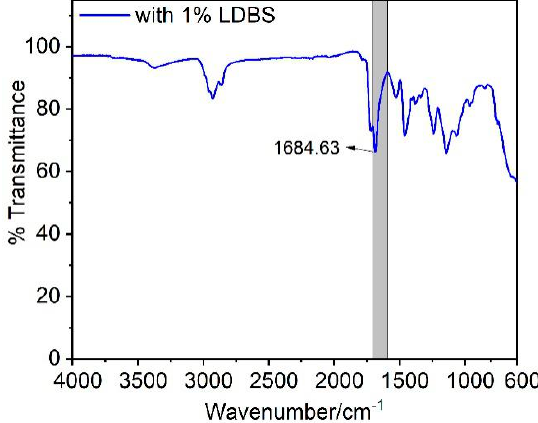
Figure 8. Integral area of the carbamate carbon’s characteristic peak of the sample with 1.0% LDBS.